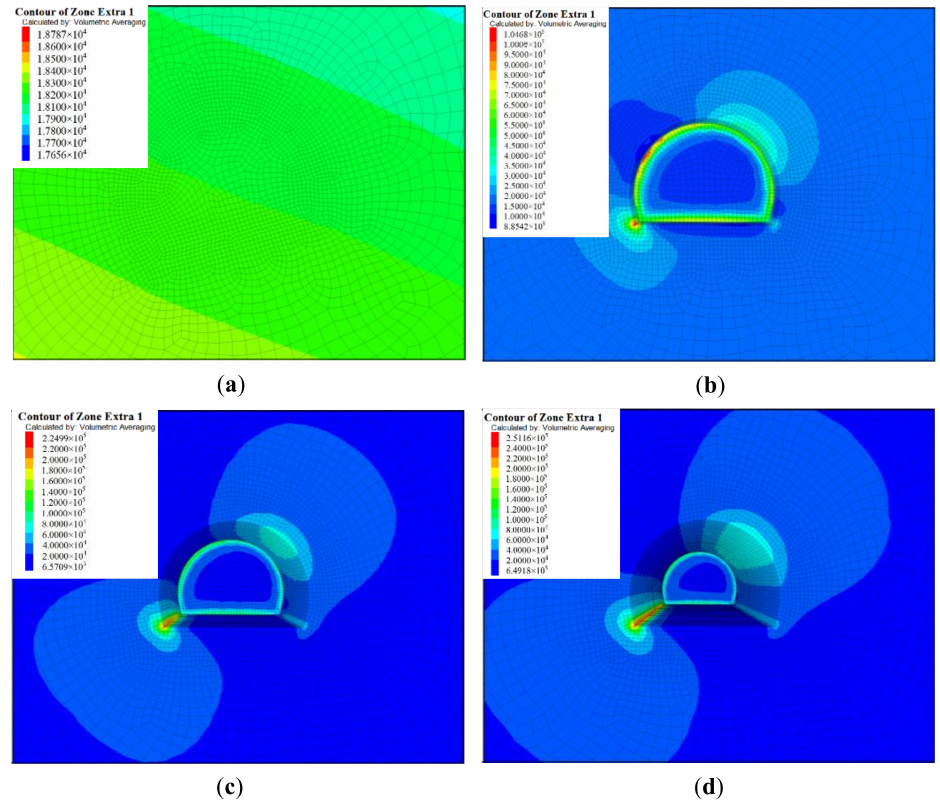
Figure 13. Cloud image of strain energy accumulation in different excavation stages: ( a ) Initial energy